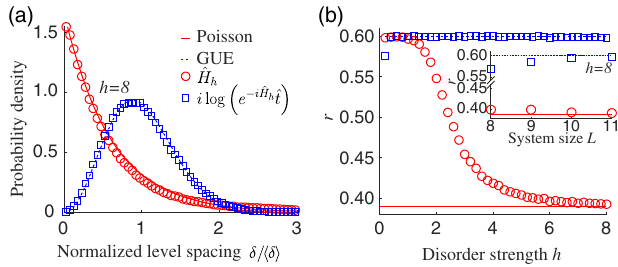
FIG. 7. Chiral edge thermalization. The presence or a using exact diagonalization for a small spin- 1 = 2 chain with size N ≤ 11 sites, and level statistics is extracted using 200 disorder realiza- tions. Red circles and blue squares respectively indicate level ˆ H statistics of and i log ð e − i ˆ H h ˆ t Þ . (a) The level spacing h δ ≡ ϵ − ϵ , where ϵ is the n th eigenvalue of the Hamiltonian n n þ 1 n n for one disorder realization, is known to show distinct statistical properties when the system is MBL or thermal. The plot shows level statistics for h ¼ 8 , and the probability density functions of the normalized level spacing δ = h δ i are well fitted to the Poisson distribution (red line) and the generalized unitary ensemble